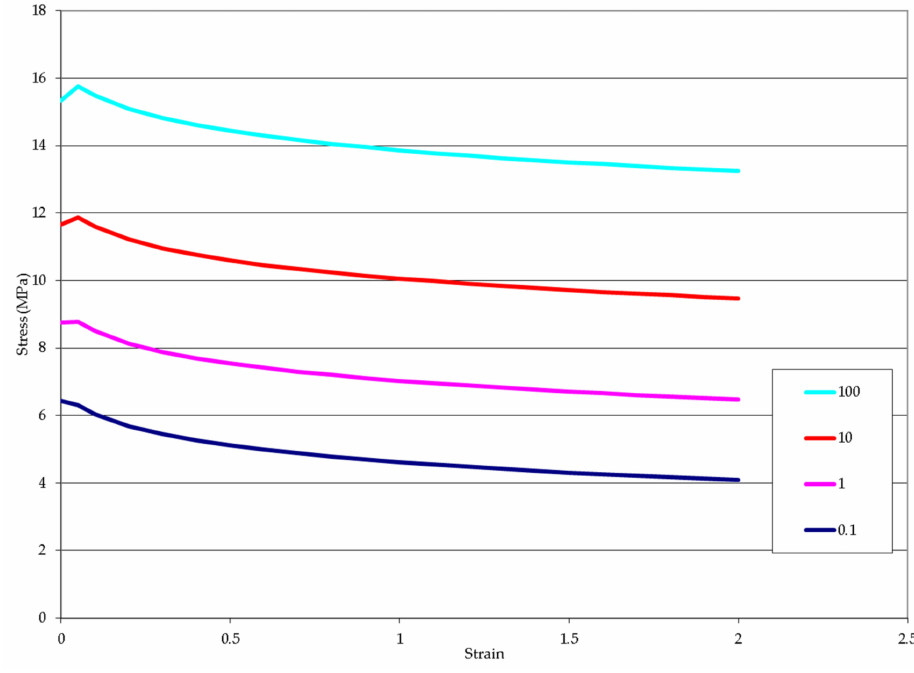
Figure 7. Strain rate–sensitive stress curves for AA 7075-T6 at 450 ◦